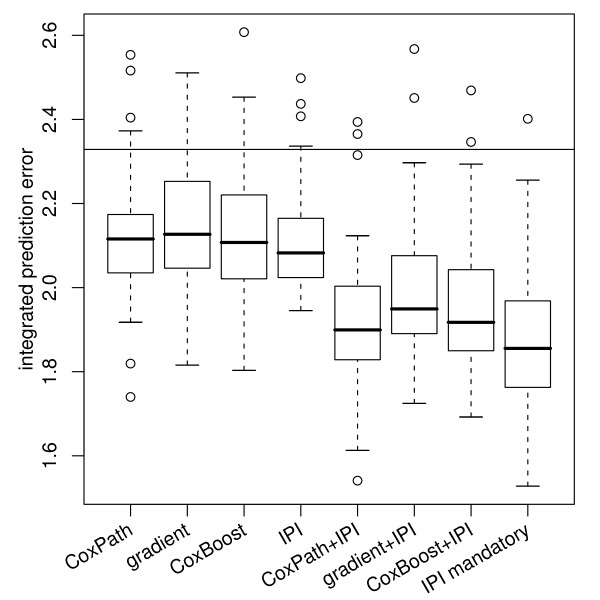
Variability of the .632+ prediction error estimates. Integrated prediction error curve estimates from single bootstrap samples for CoxPath, gradient boosting, componentwise CoxBoost, and an IPI-only Cox model ("IPI"), for corresponding models where the IPI is included as a an additional optional covariate ("...+IPI"), and for CoxBoost fits that incorporate the IPI as a mandatory covariate ("IPI mandatory"). The Kaplan-Meier benchmark value is indicate by a horizontal line.